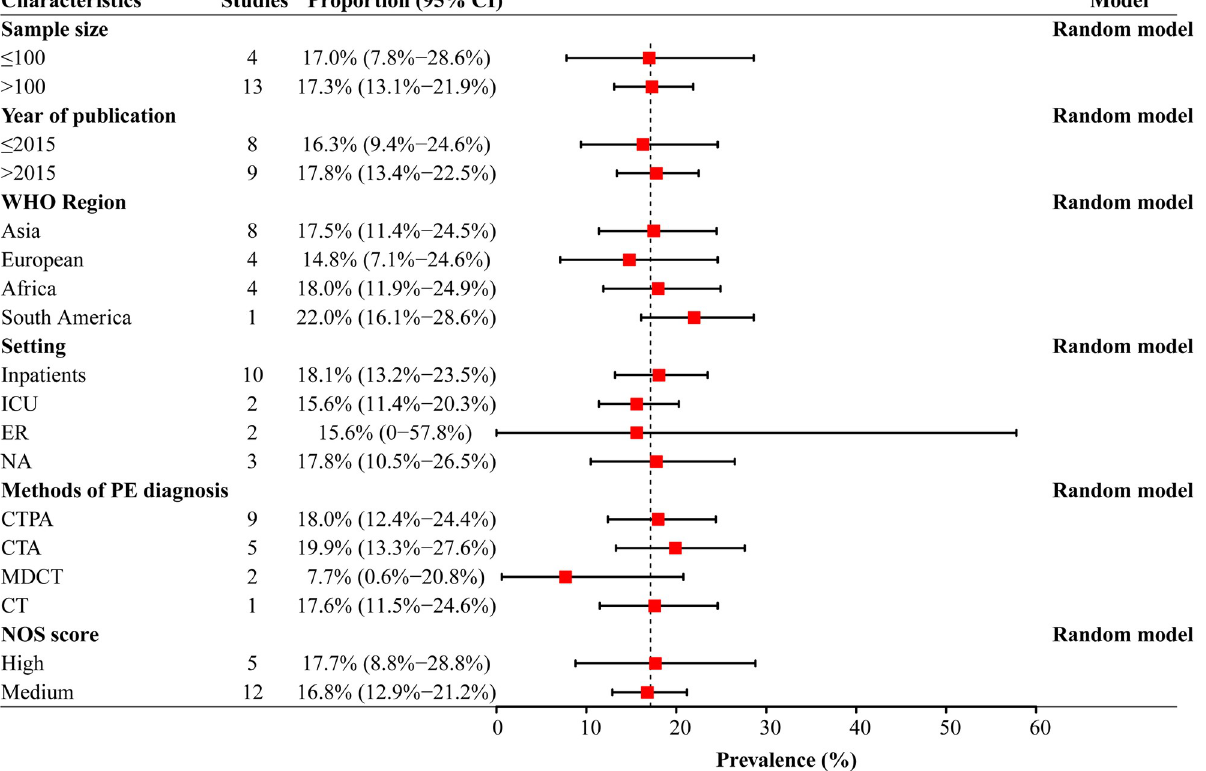
Fig 3. Subgroup analysis of PE prevalence in AE-COPD patients.